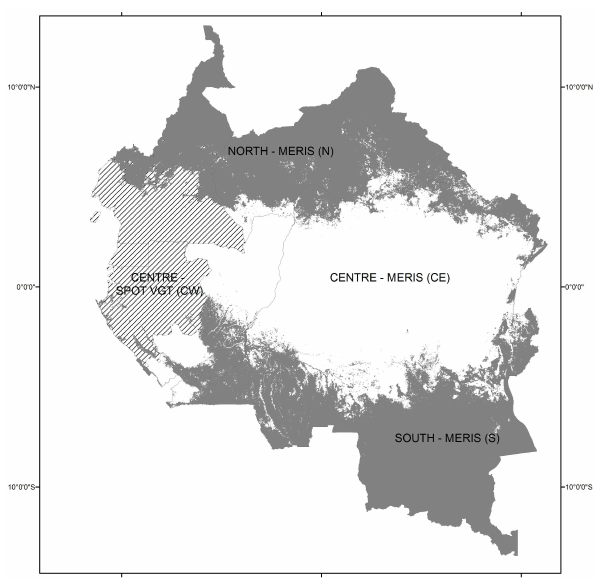
Fig. 1. Stratification of the study area in four zones: North (N), South (S), Western Centre (CW) and Eastern Centre (CE). SPOT VGT is used for hatched countries while MERIS is used for the